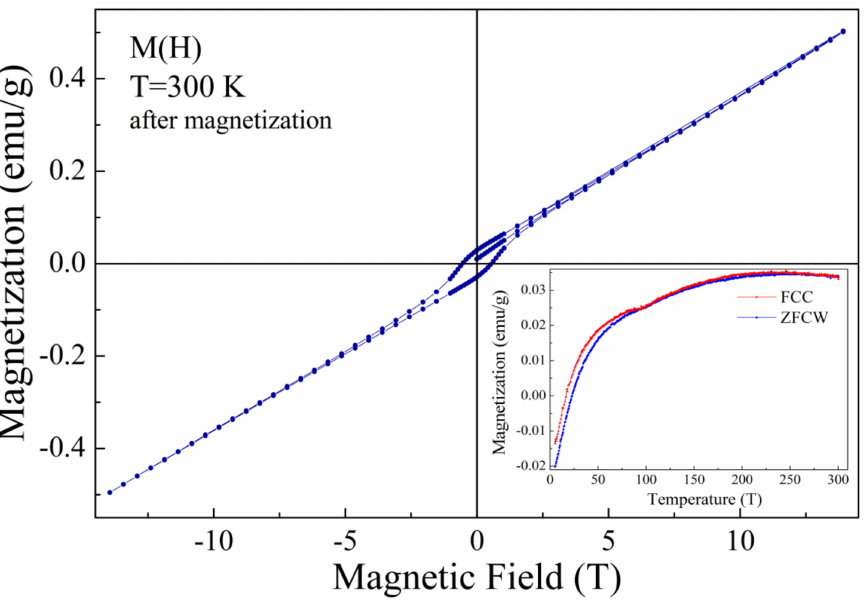
Figure 6. Isothermal magnetization dependence recorded at 300 K for the compound subjected to external magnetic field of 14 T. The inset shows ZFC and FC dependencies measured at 100